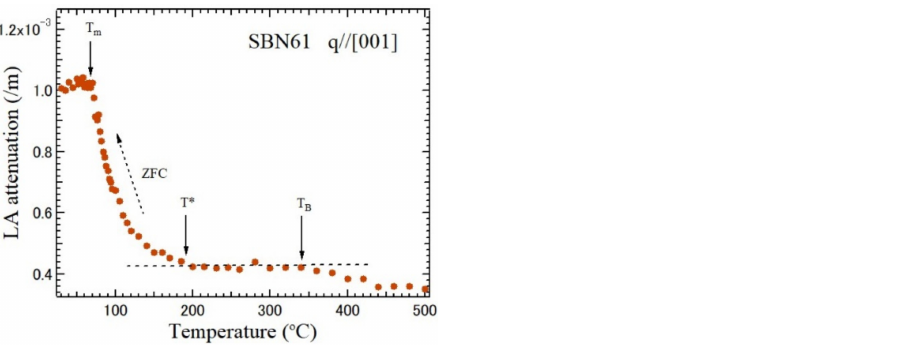
Figure 10. Temperature dependence of LA attenuation of SBN61 observed on zero-field cooling (ZFC), where T B = 350 ◦ C, T * = 190 ◦ C, and T m = 72 ◦ C [70].